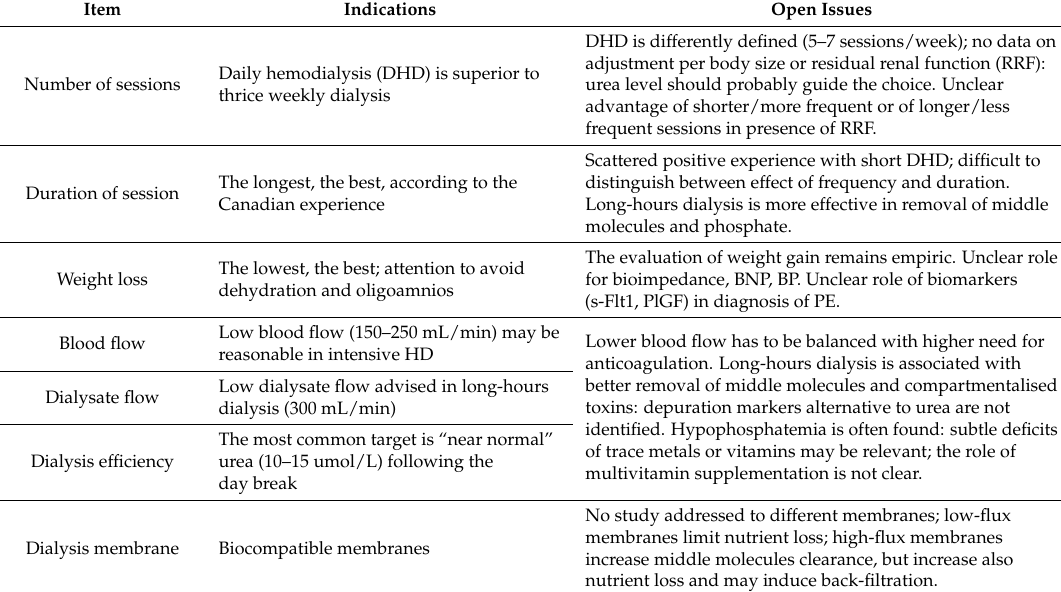
Table 5. Some challenges and open questions in the practical management of hemodialysis patients in